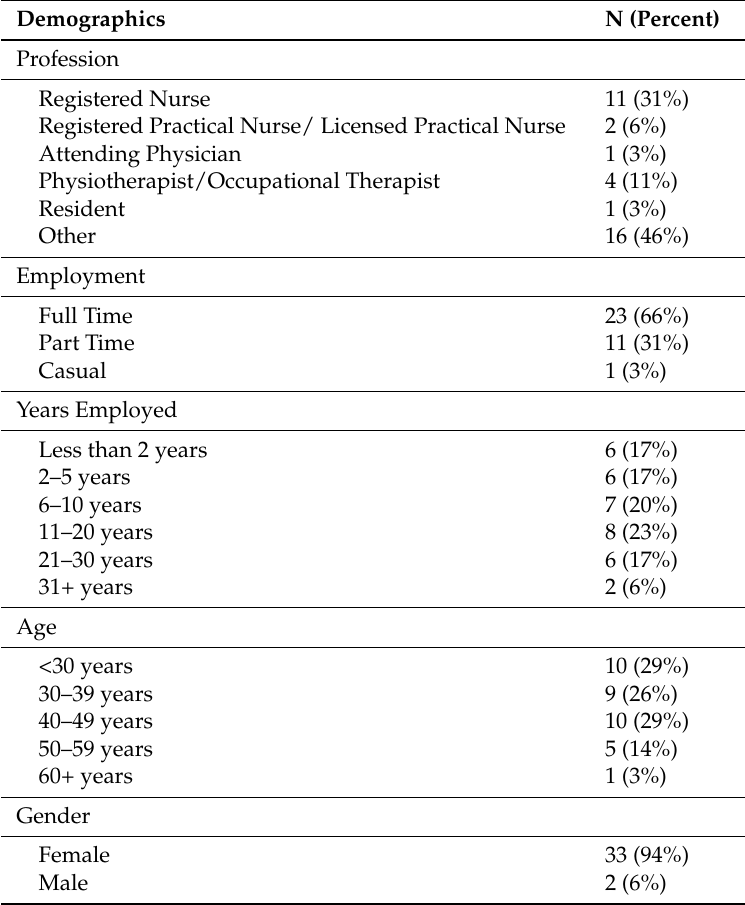
Table 1. Study 1: Demographics for test retest reliability participants (n = 35).